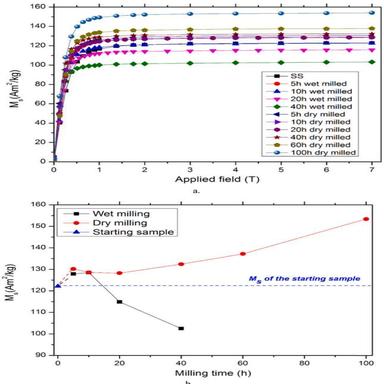
Magnetic properties recorded at room temperature on Fe38.5Co38.5Nb7B15Cu1 powders wet and dry milled up to 40 and 100 h, respectively. a. - The first magnetisation curves for the Fe38.5Co38.5Nb7B15Cu1 powders; b. - Evolution of saturation magnetisation of wet and dry milled samples versus milling time (the estimated error of the saturation magnetization is a maximum of ± 2.0%).